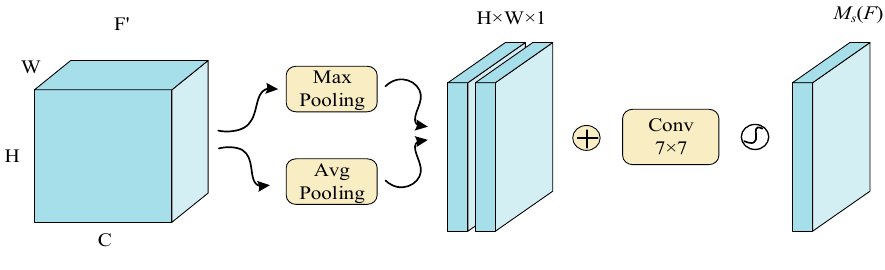
Figure 4. SAM module structure.